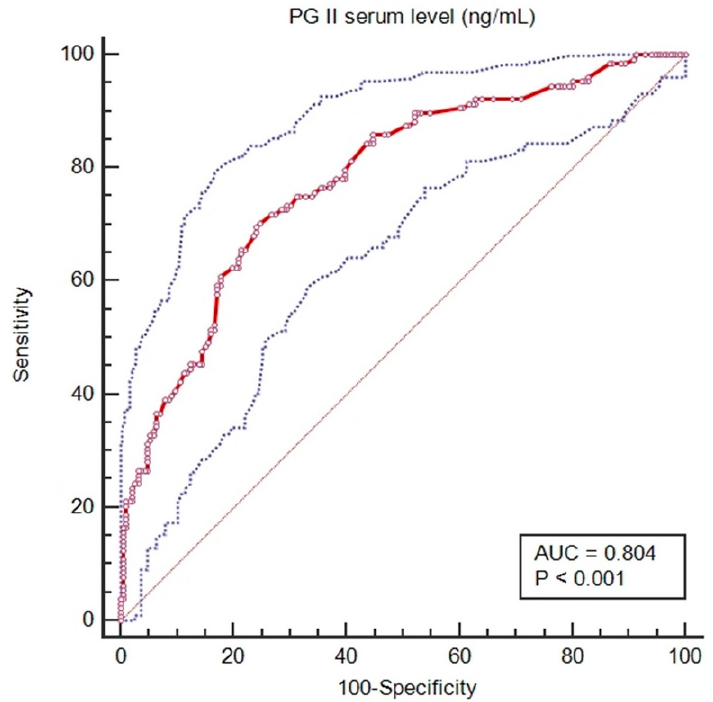
Figure 3. Receiver operating characteristic curve for predicting the presence of anti- H. pylori IgG from serum Pepsinogen (PG) II levels.